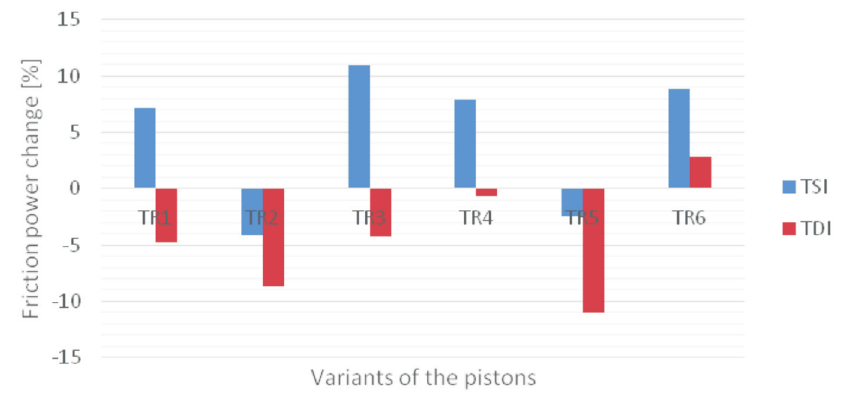
Fig. 7. The percentage difference of friction power for six variants of the piston bearing surface for the SI and CI engines